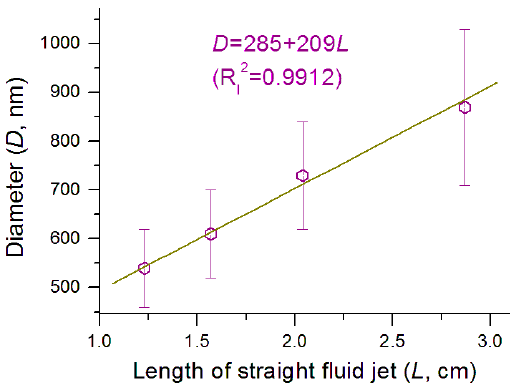
Figure 8. The interrelation between the length of the straight fluid jet and the fibers’ diameter.